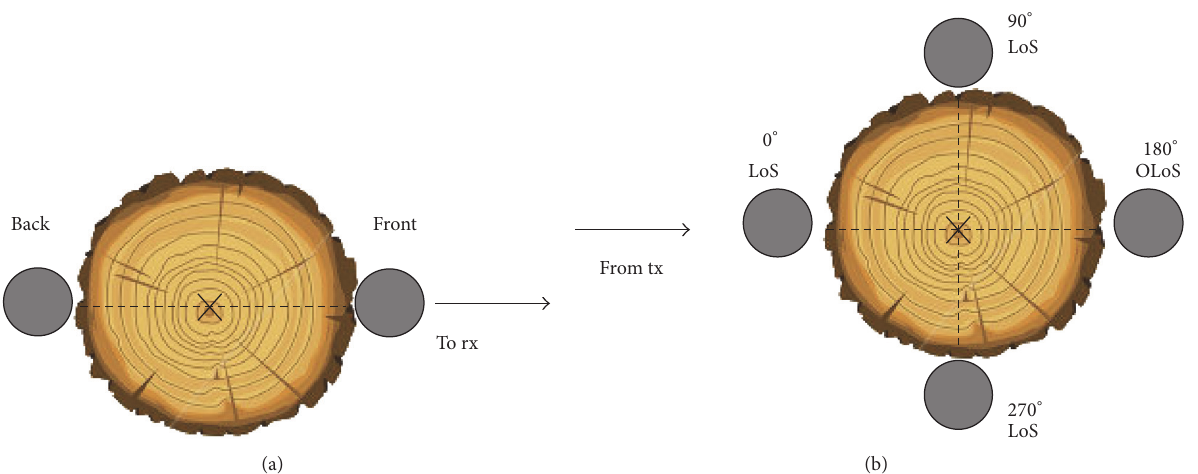
Figure 1: Geometrical disposition of antenna spots at each measurement location: (a) transmitter end; (b) receiver end.